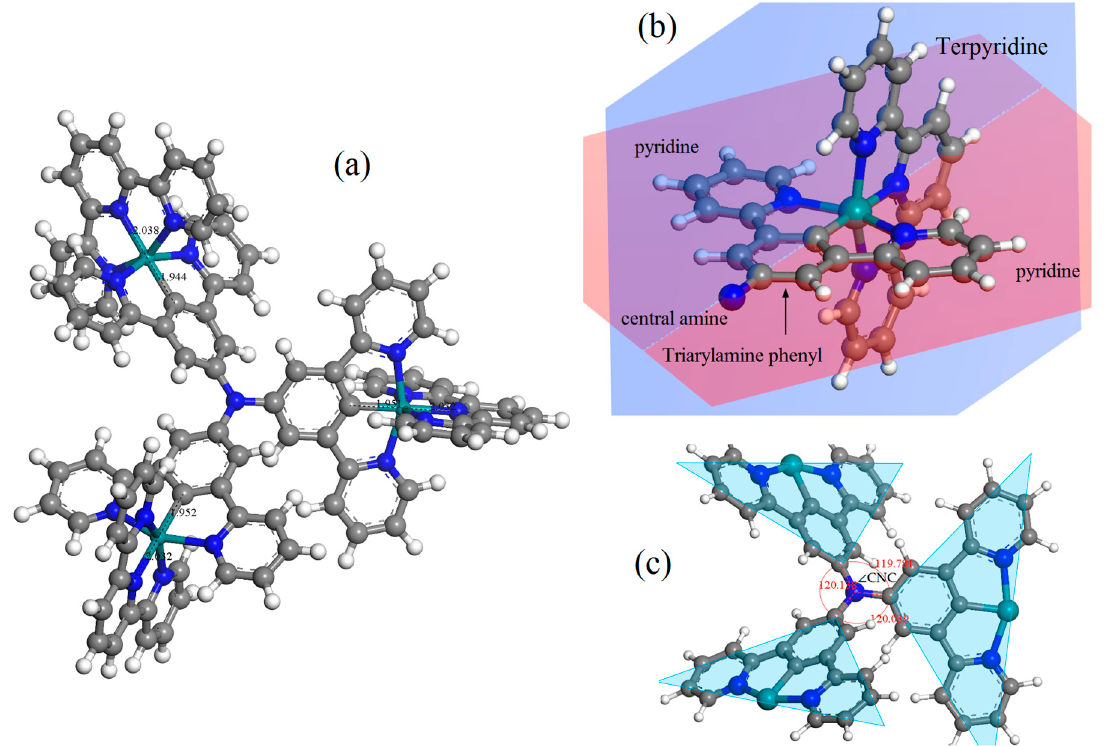
Figure 2. ( a ) Geometrically optimized molecular configuration and ( b , c ) the scaled local schematics showing atomic planes